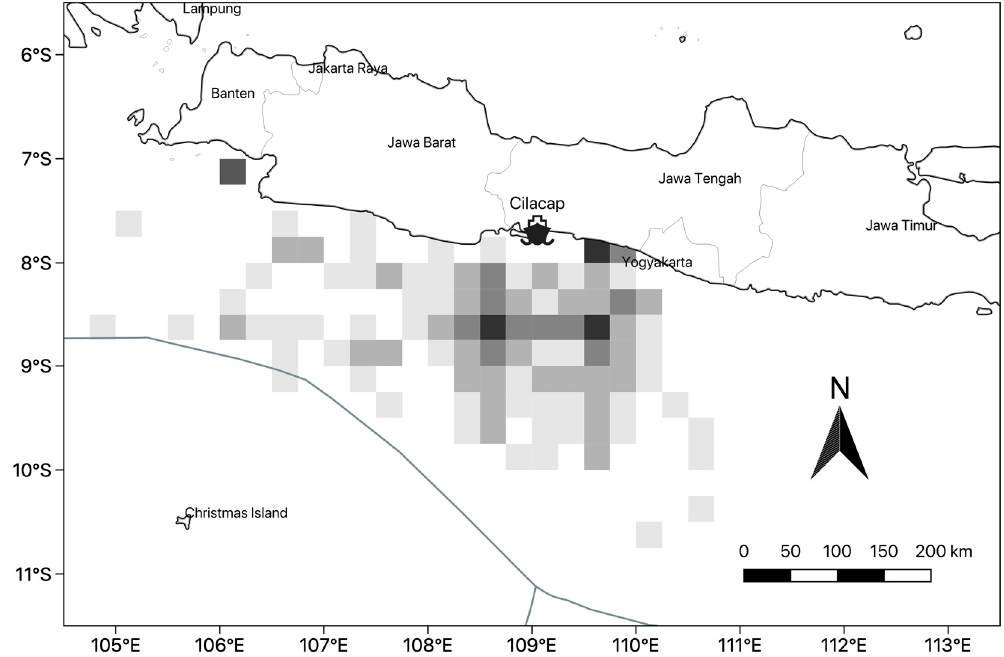
Figure 2. Distribution of drifting gillnet fishery efforts by ¼ degree blocks, with darker and lighter colors representing intensity (in days at sea).